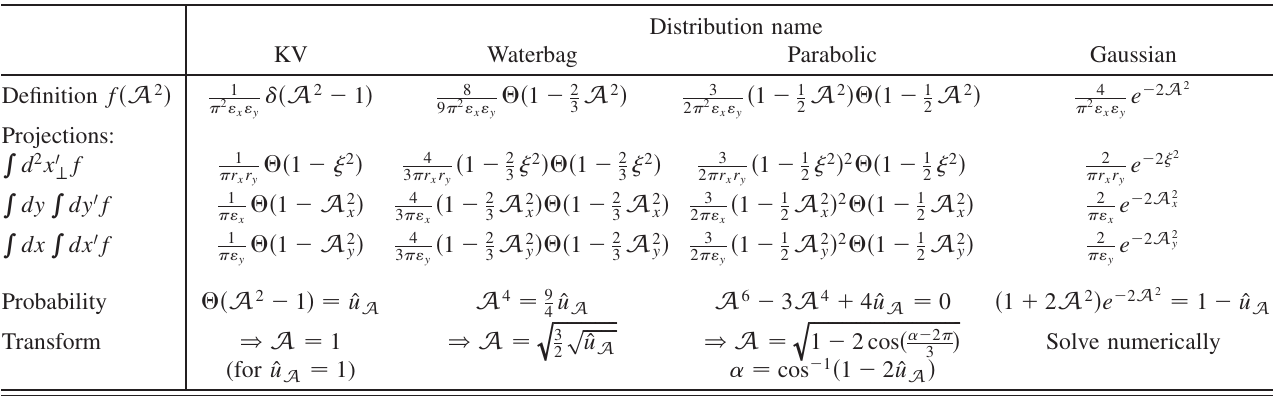
TABLE II. Characteristics of linear-field Courant-Snyder distributions generated for choices of f ð A 2 Þ . Here, (cid:13) 2 (cid:4) ð x=r Þ 2 ð y=r y